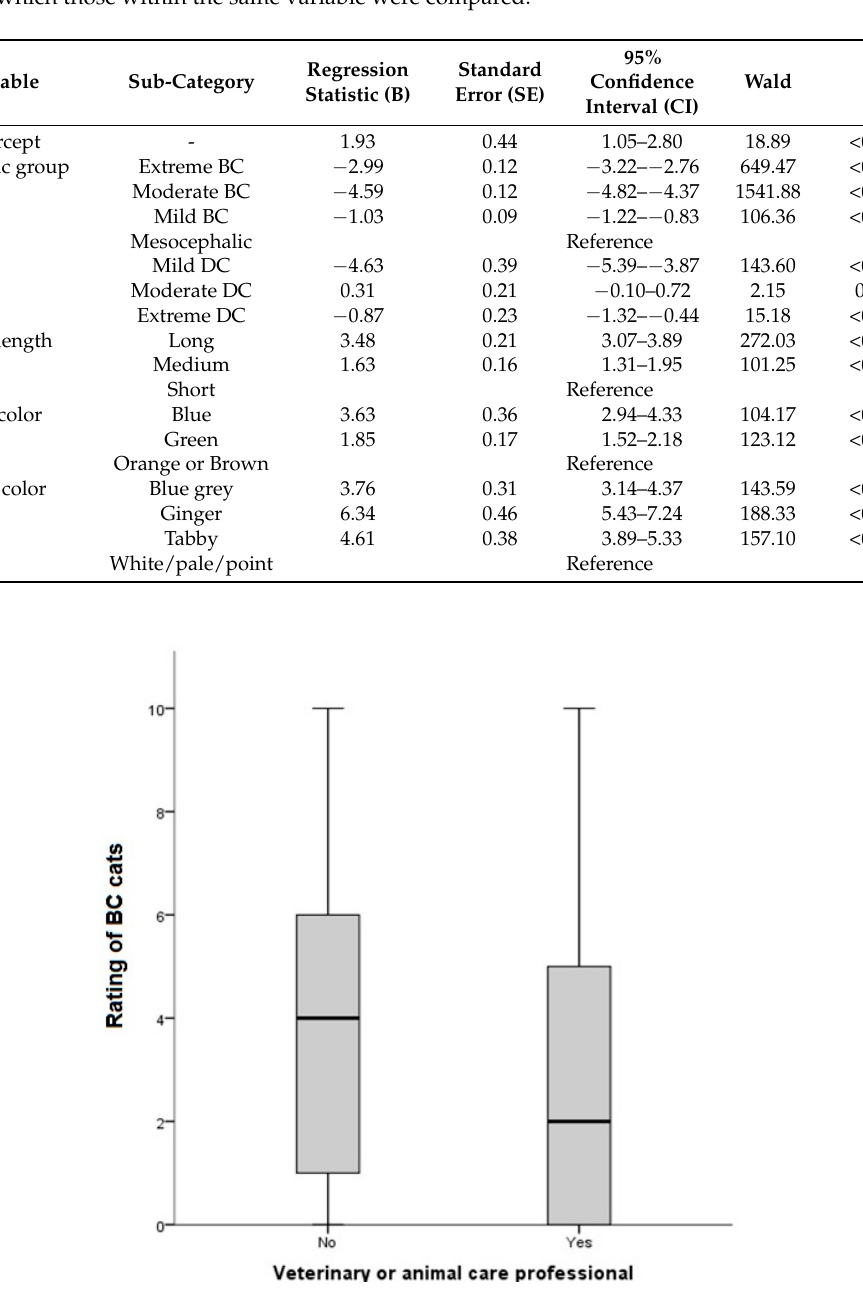
Figure 2. Significant differences (KW = 277.9, df = 2, p < 0.001) in ratings of brachycephalic (BC) cat images ( n = 7/15; as per Table 1) between respondents that identified as veterinary or animal care professionals ( n = 244) as opposed to those that did not ( n =